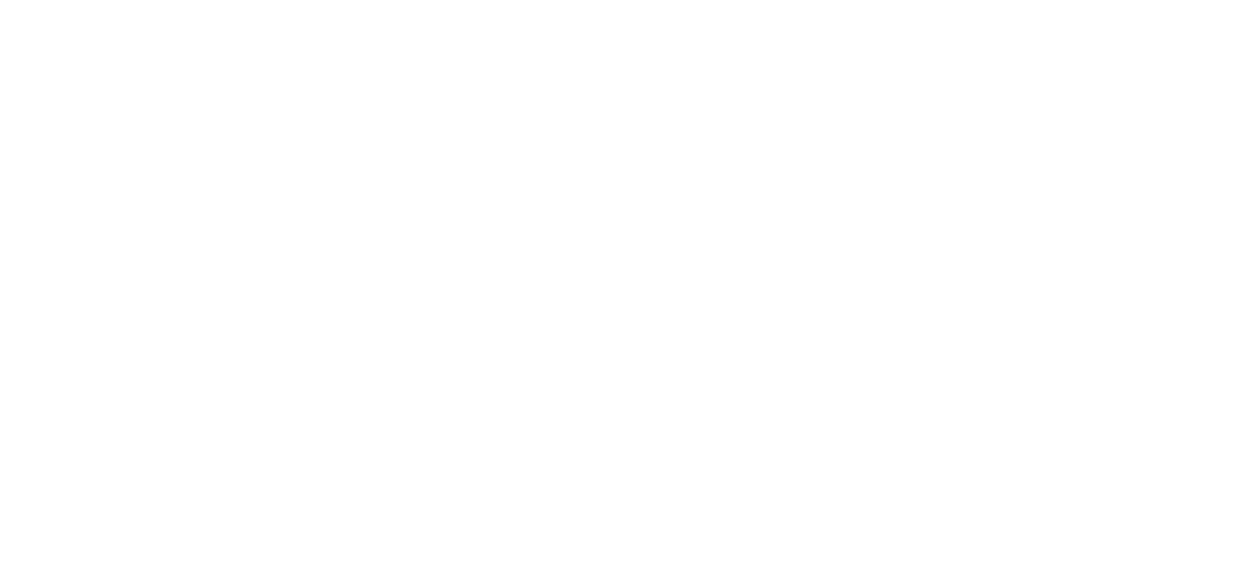
Frontiers in Plant Science | www.frontiersin.org